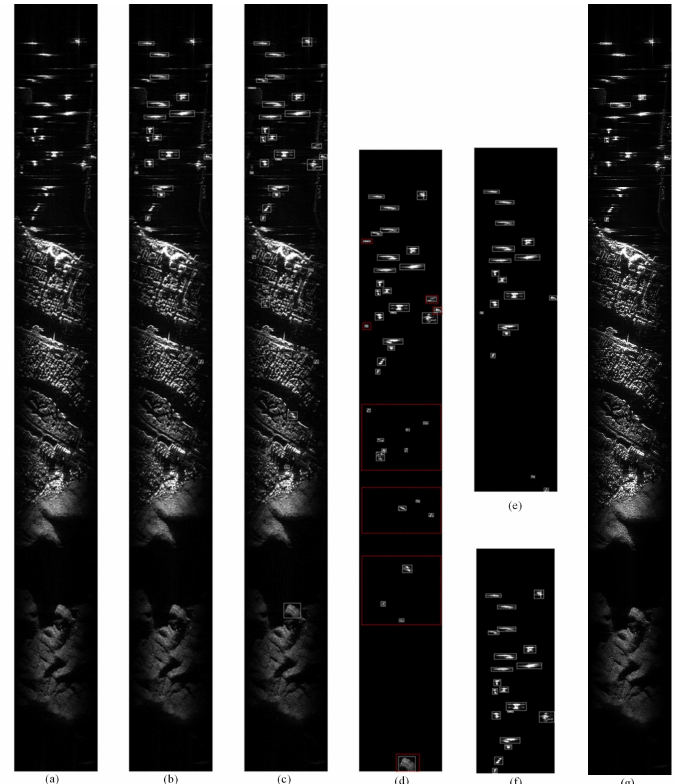
Figure 17. Comparison of detection results between the reference algorithm and proposed algorithm. ( a ) SAR focus image to be detected; ( b ) Reference algorithm detection results; ( c ) The rough detection results of the proposed algorithm; ( d ) Extraction of rough detection results of the proposed algorithm; ( e ) Reference algorithm detection result extraction; ( f ) Extraction of precise detection results using the proposed algorithm; ( g ) Results based on deep learning